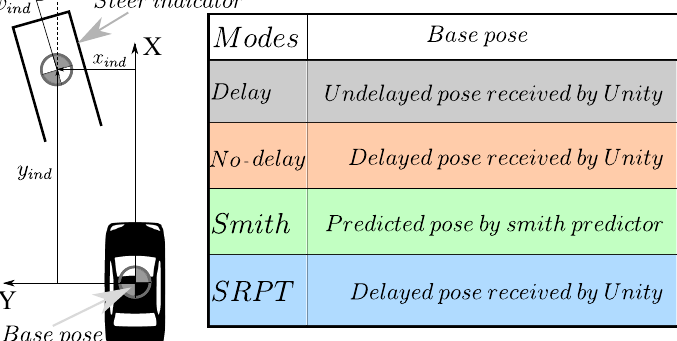
Figure 4. Steer indicator in respective modes.